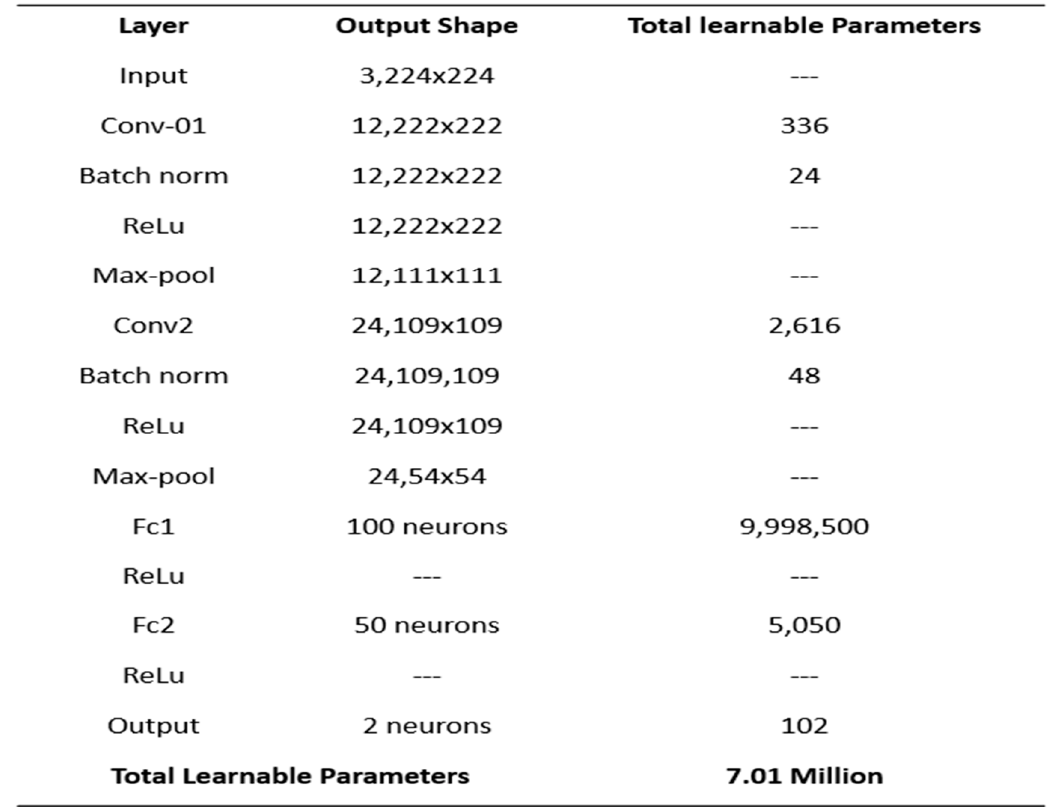
Figure 5. Internal block diagram for PV-CrackNet.